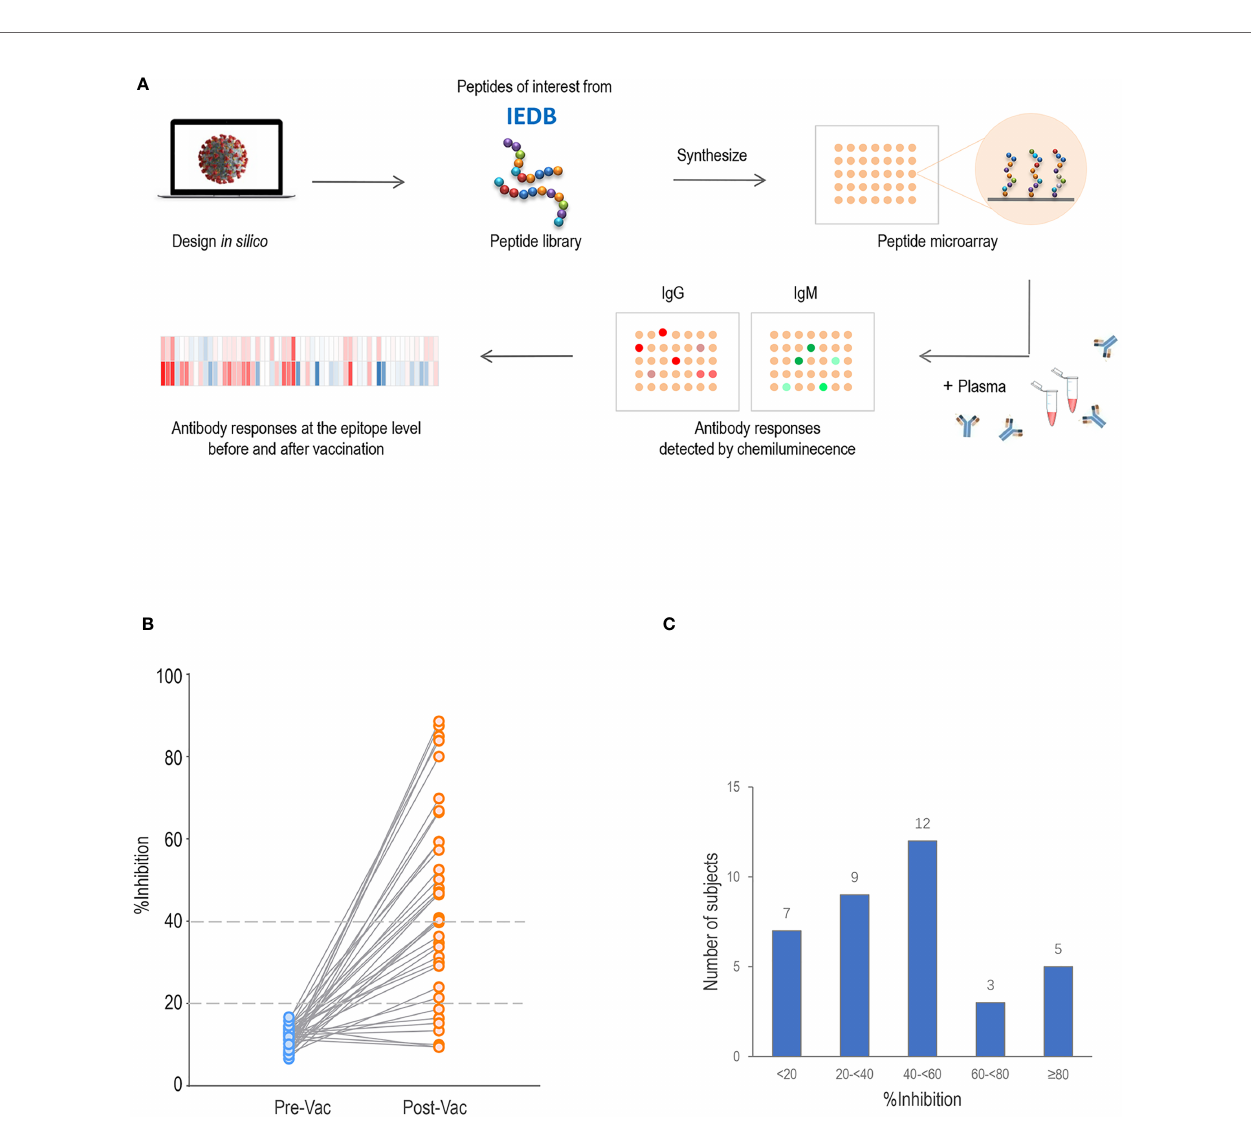
FIGURE 1 | Proteome microarray and neutralization inhibition rate (%inhibition) of serum samples. (A) Schematic illustration of SARS-CoV-2 proteome microarray fabrication and application. (B) The %inhibition of pre-vaccination (Pre-Vac) and post-vaccination (Post-Vac) sera samples from 36 healthy volunteers vaccinated with inactivated COVID-19 vaccines. (C) The number of participants with %inhibition <20%, 20% to <40%, 40% to <60%, 60 – <80% and ≥